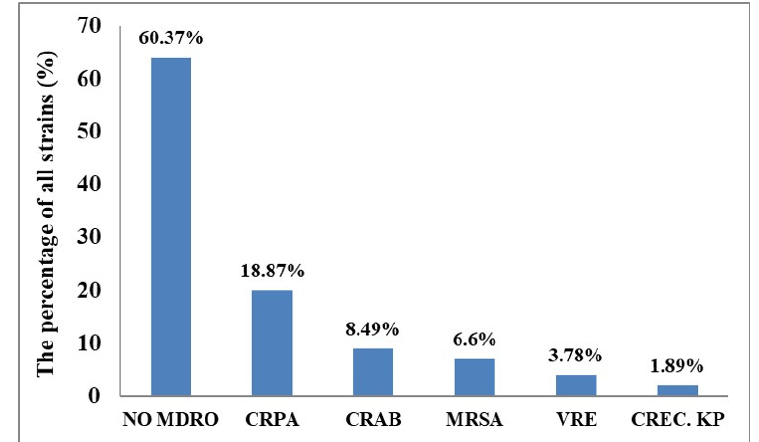
Figure 2. Strain percentages comprising all HAI.